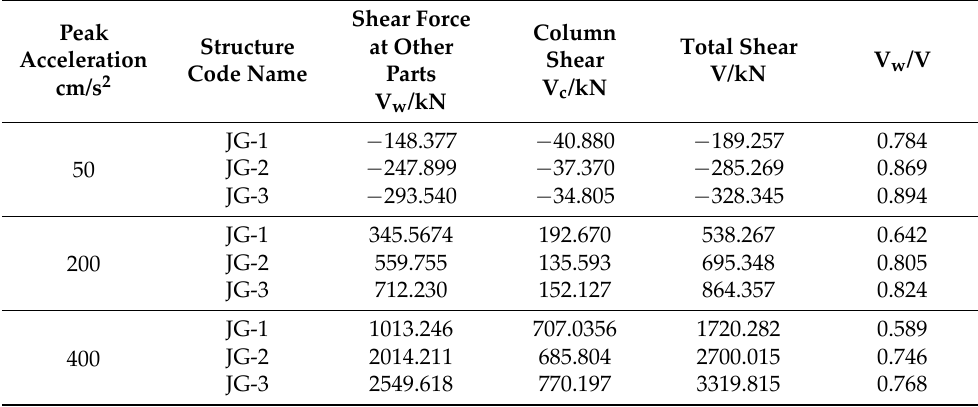
Table 4. The contrast of base shear